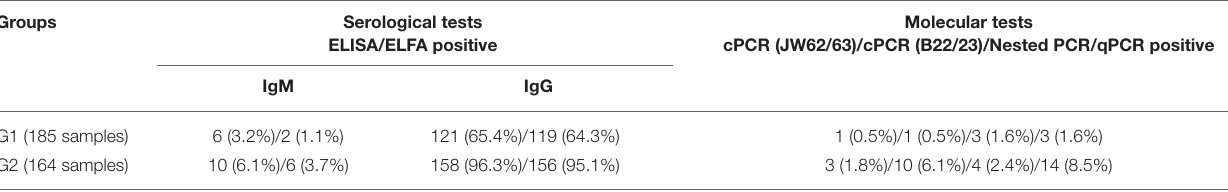
TABLE 1 | Comparison of serological and molecular tests of group without ocular toxoplasmosis (G1) with group with ocular toxoplasmosis (G2). Groups